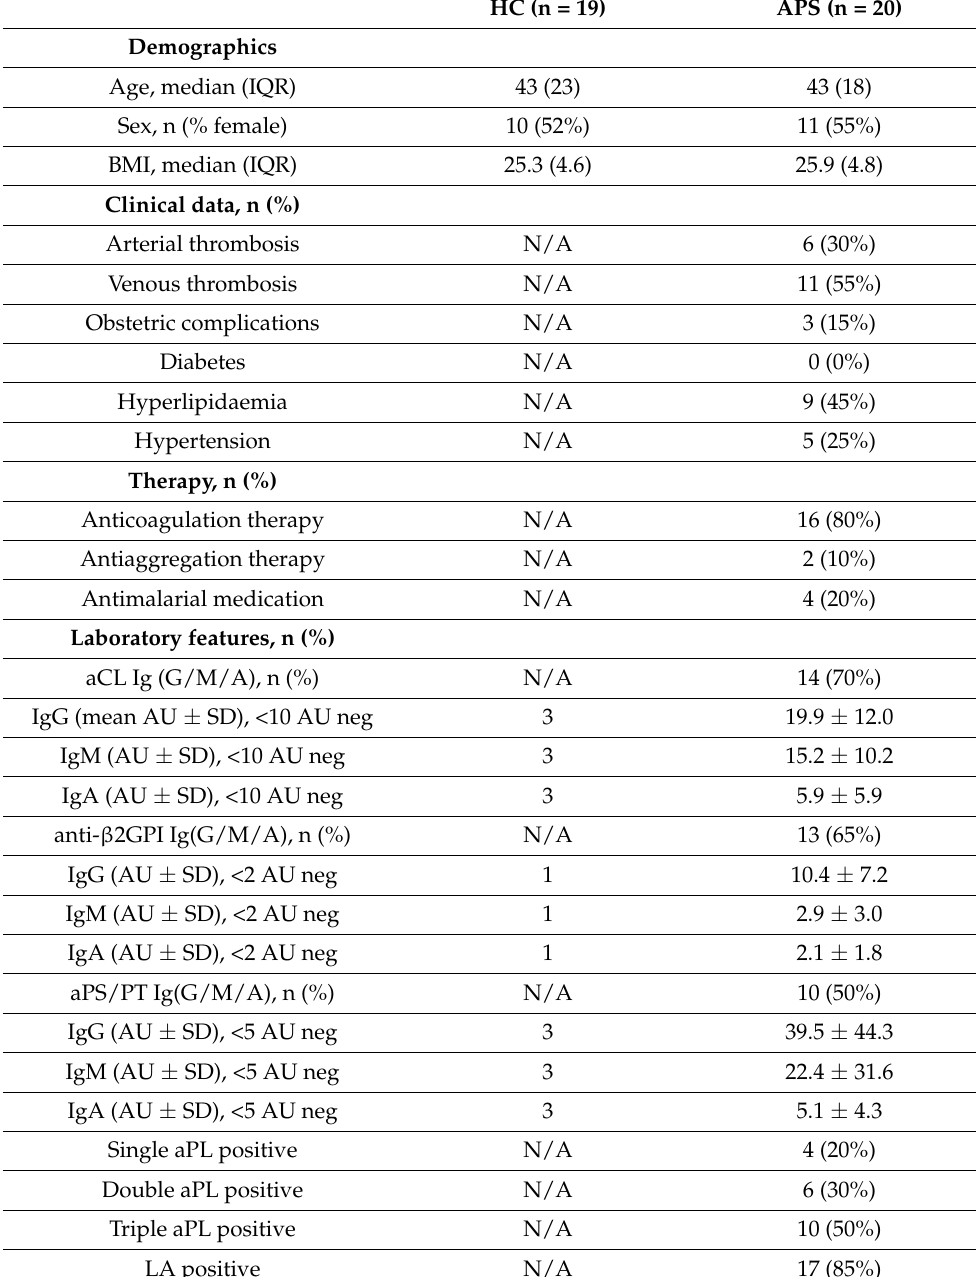
Table 1. Patients’ demographics, clinical and laboratory